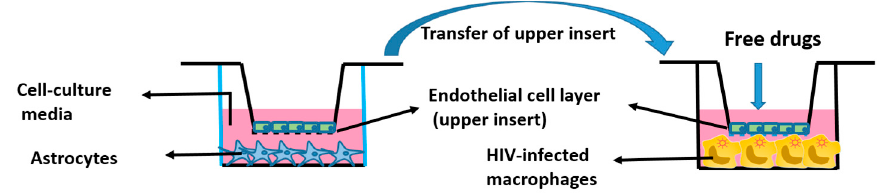
Figure 1. Graphical representation of the in vitro human BBB